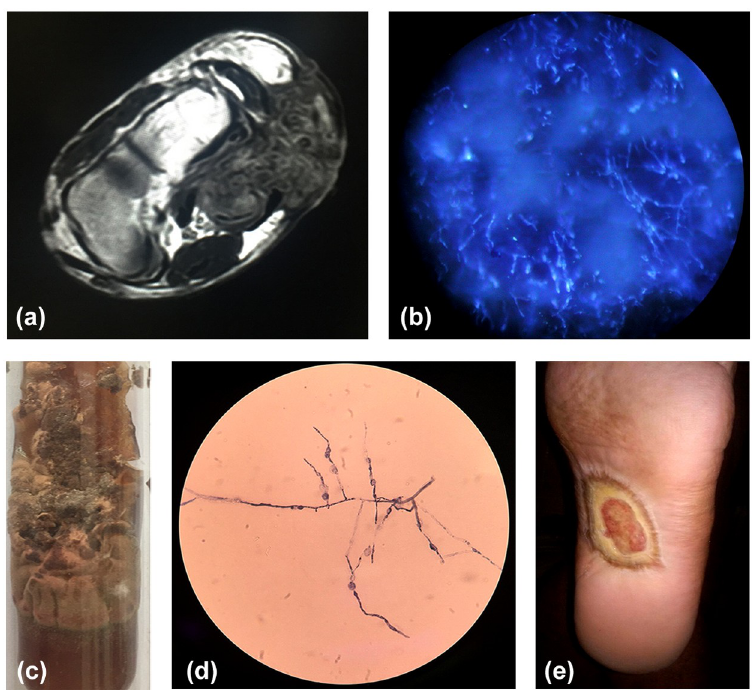
Fig 1. Clinical features and diagnostic findings in the present case with eumycetoma. (A) MRI (T2) of the left foot showing heterogeneously enhancing soft tissue with “Dot in Circle” sign (white arrow). ( B) KOH - calcofluor white staining of the grain showing compact septate hyphae. ( C) Growth on Sabouraud Dextrose Agar. (D) Lactophenol cotton blue mount of the microculture from the colony showing Madurella sp. (E) Lesion after surgical treatment.